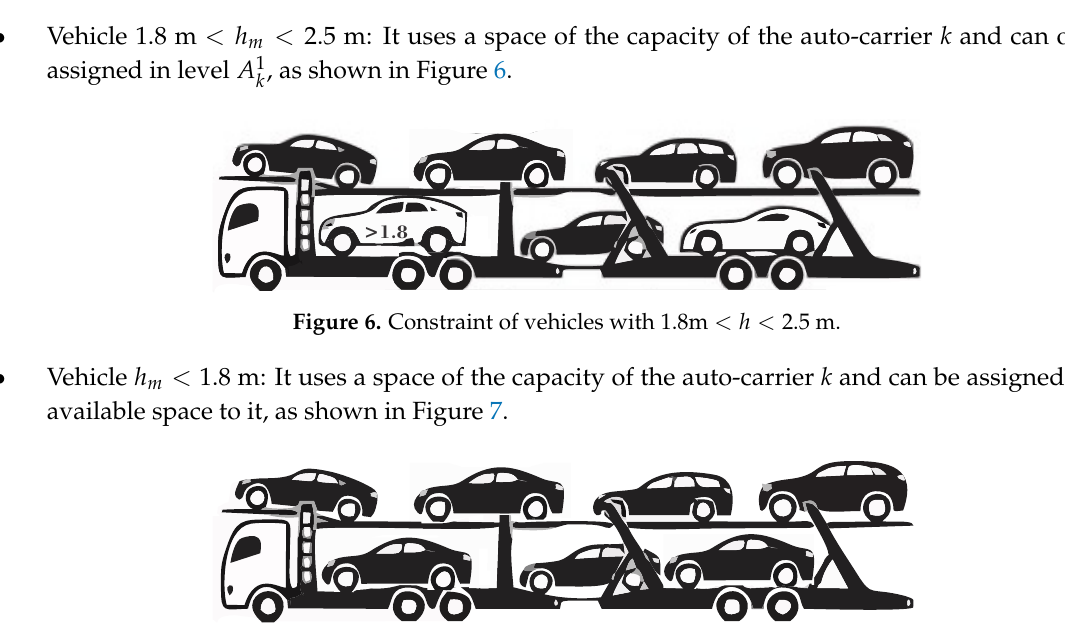
Figure 5. Constraint of vehicles with h > 2.5 m.